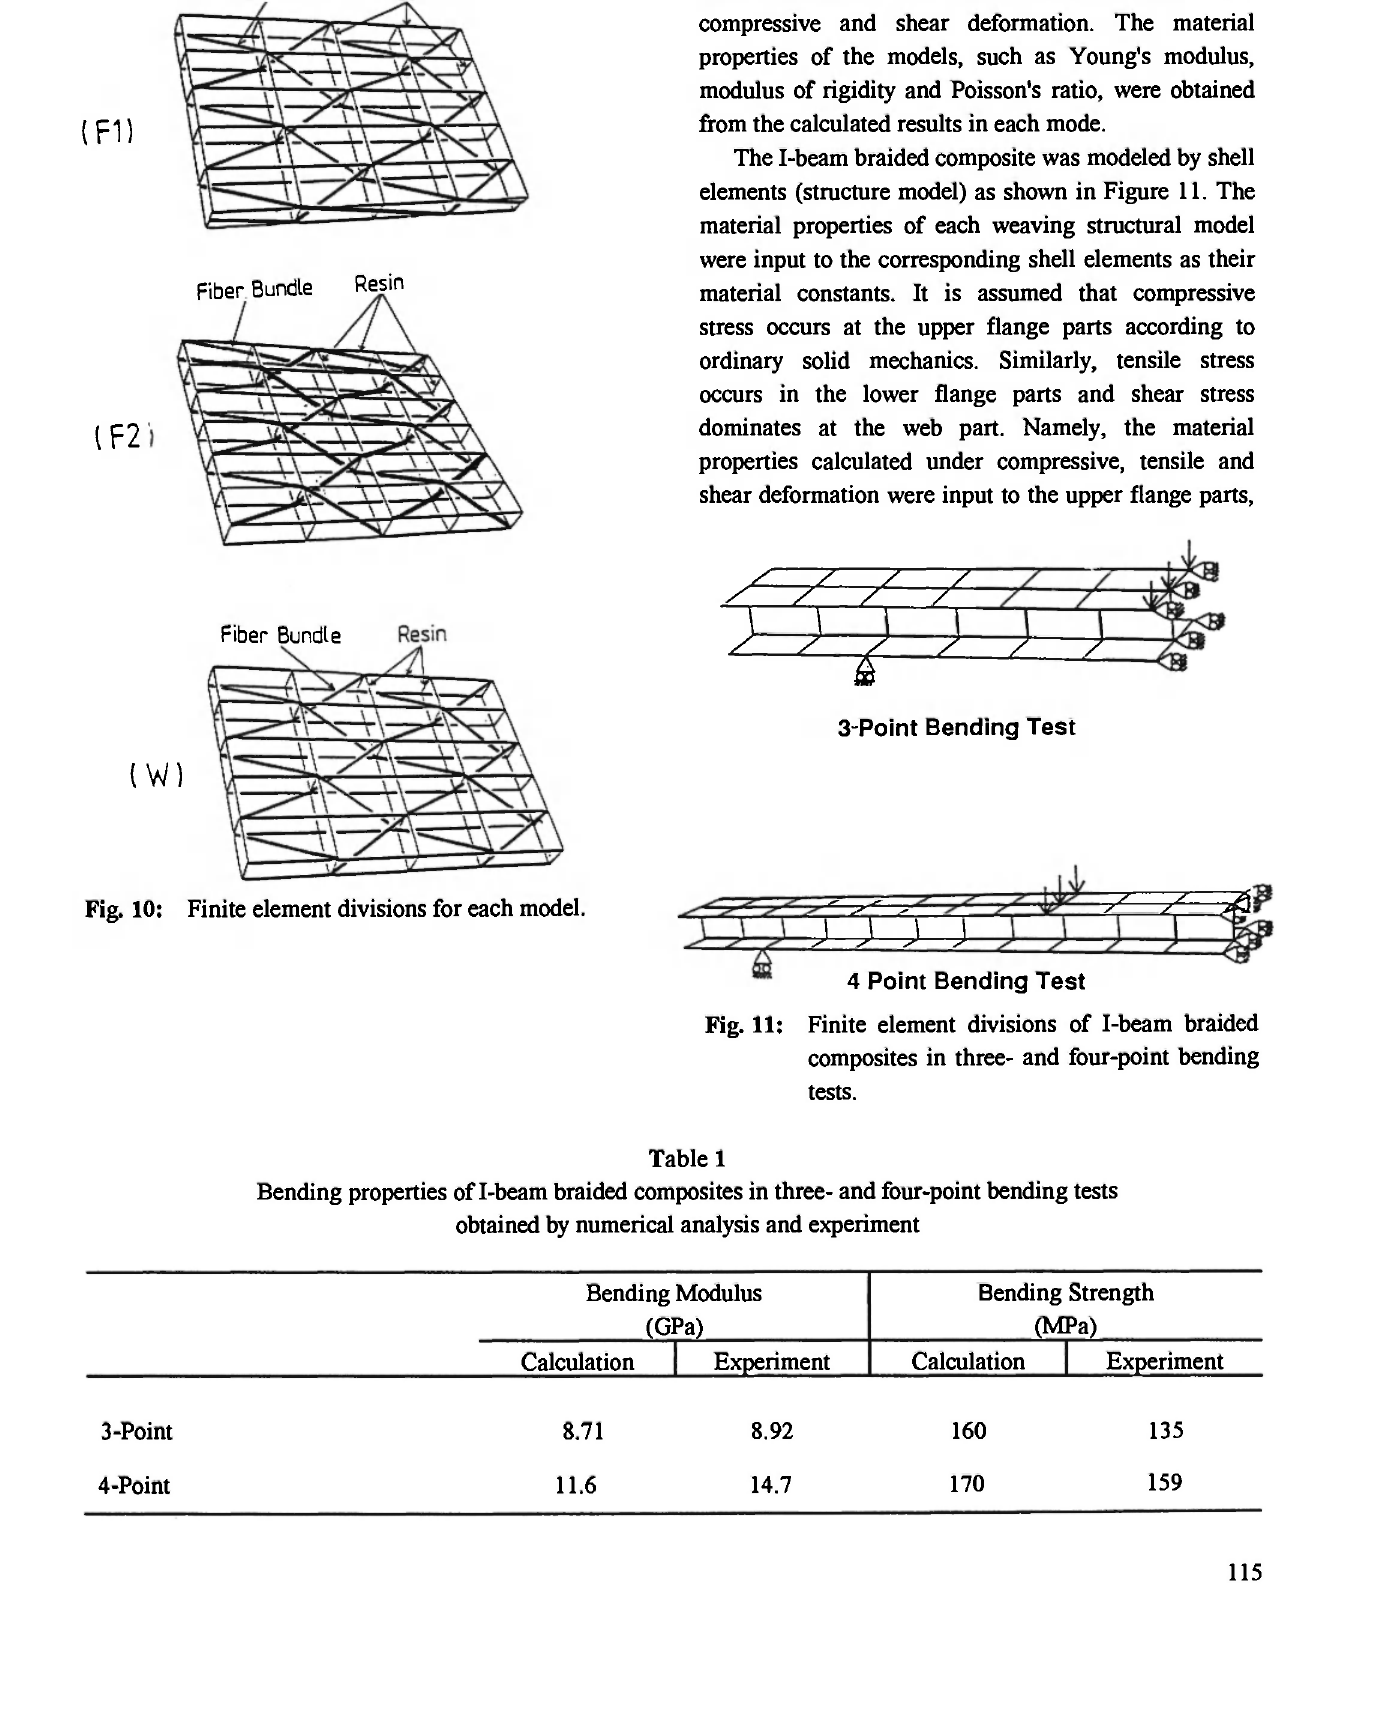
Fig. 11: Finite element divisions of I-beam braided composites in three- and four-point bending